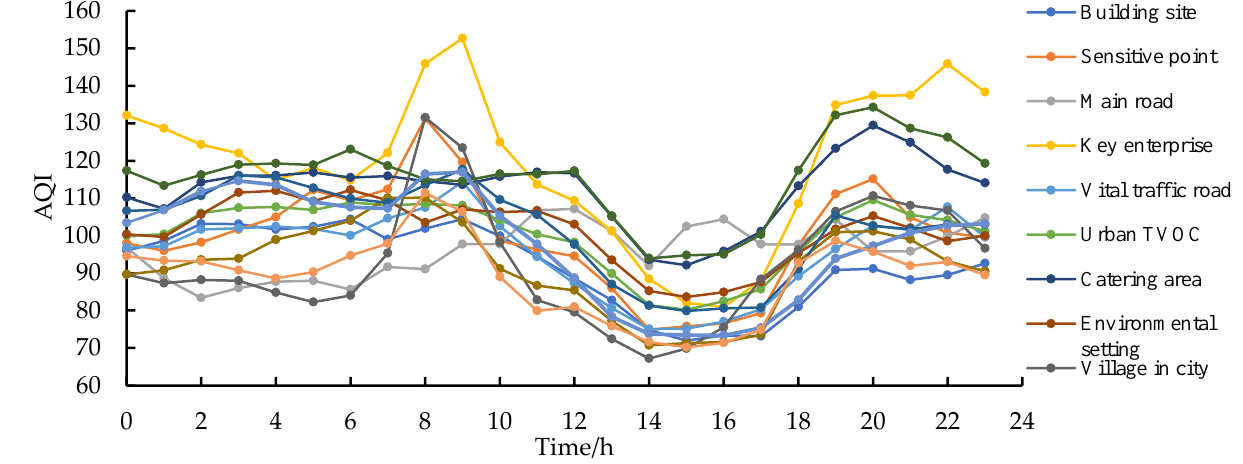
Figure 3. Correlation matrix between AQI with concentrations of six pollutants.